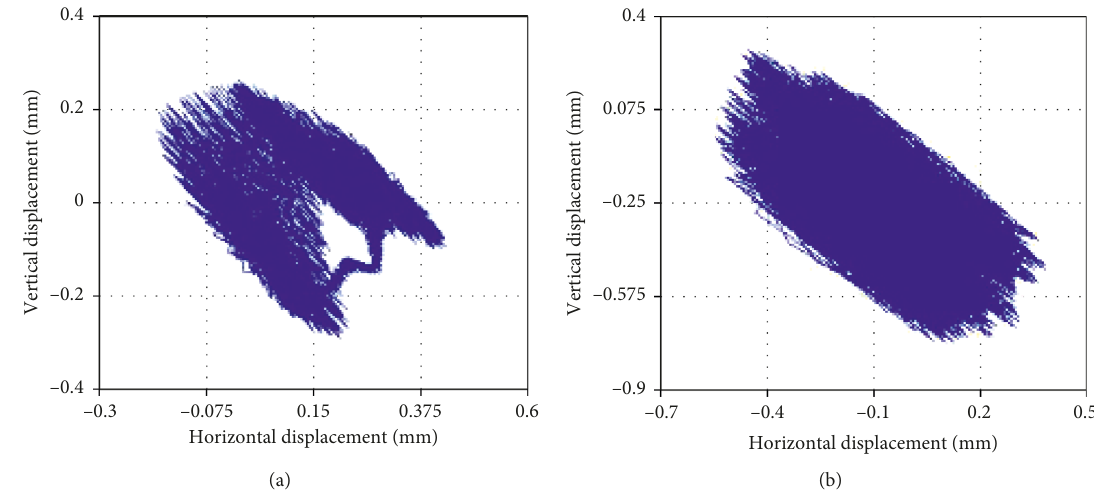
Figure 7: Axis trajectory of cylinder II. (a) Under no-load condition. (b) Under threshing condition.